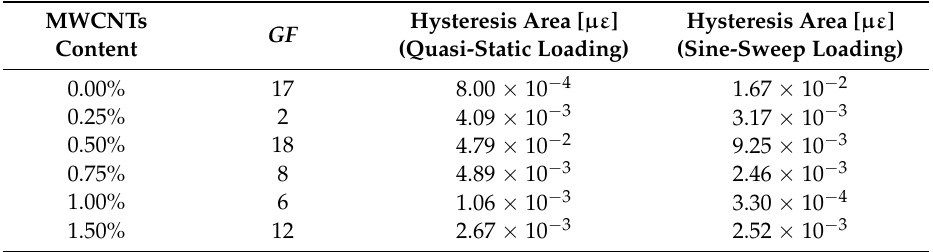
Table 3. Summary of the strain sensitivity analyses conducted on cured nanocomposite cement paste specimens, including Gauge Factors (GFs), and the hysteresis areas of the relative change in electrical resistance versus applied strain curves, considering both quasi-static and sine-sweep dynamic compression loads.